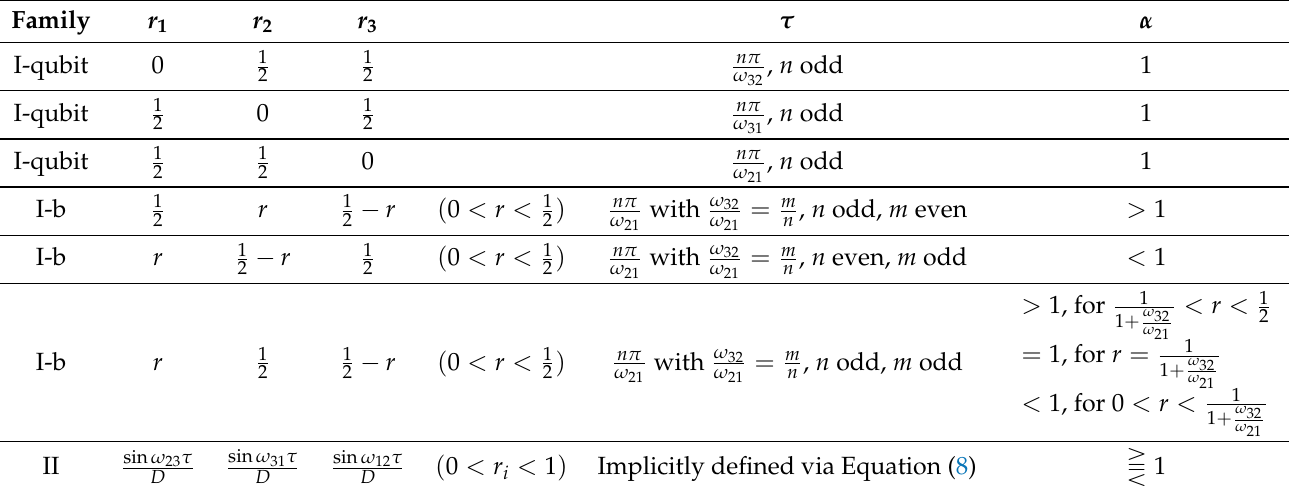
Table 1. Complete set of expansion coefficients { r i } that satisfy the orthogonality condition, the corresponding orthogonality time τ (in terms of the energy-separation levels of the Hamiltonian) and the ratio α that determines whether the quantum speed limit is given by the Mandelstam–Tamm bound ( α < 1) or the Margolus–Levitin bound ( α > 1). We denote D = sin ω 23 τ + sin ω 31 τ + sin ω 12 τ